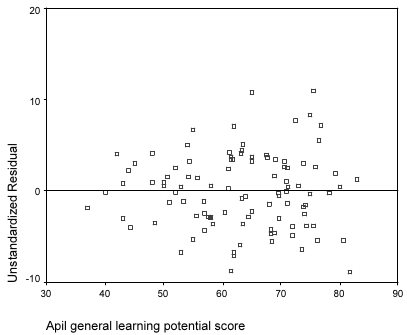
Figure 1: Real, algebraic unstandardized residuals plotted against learning potential